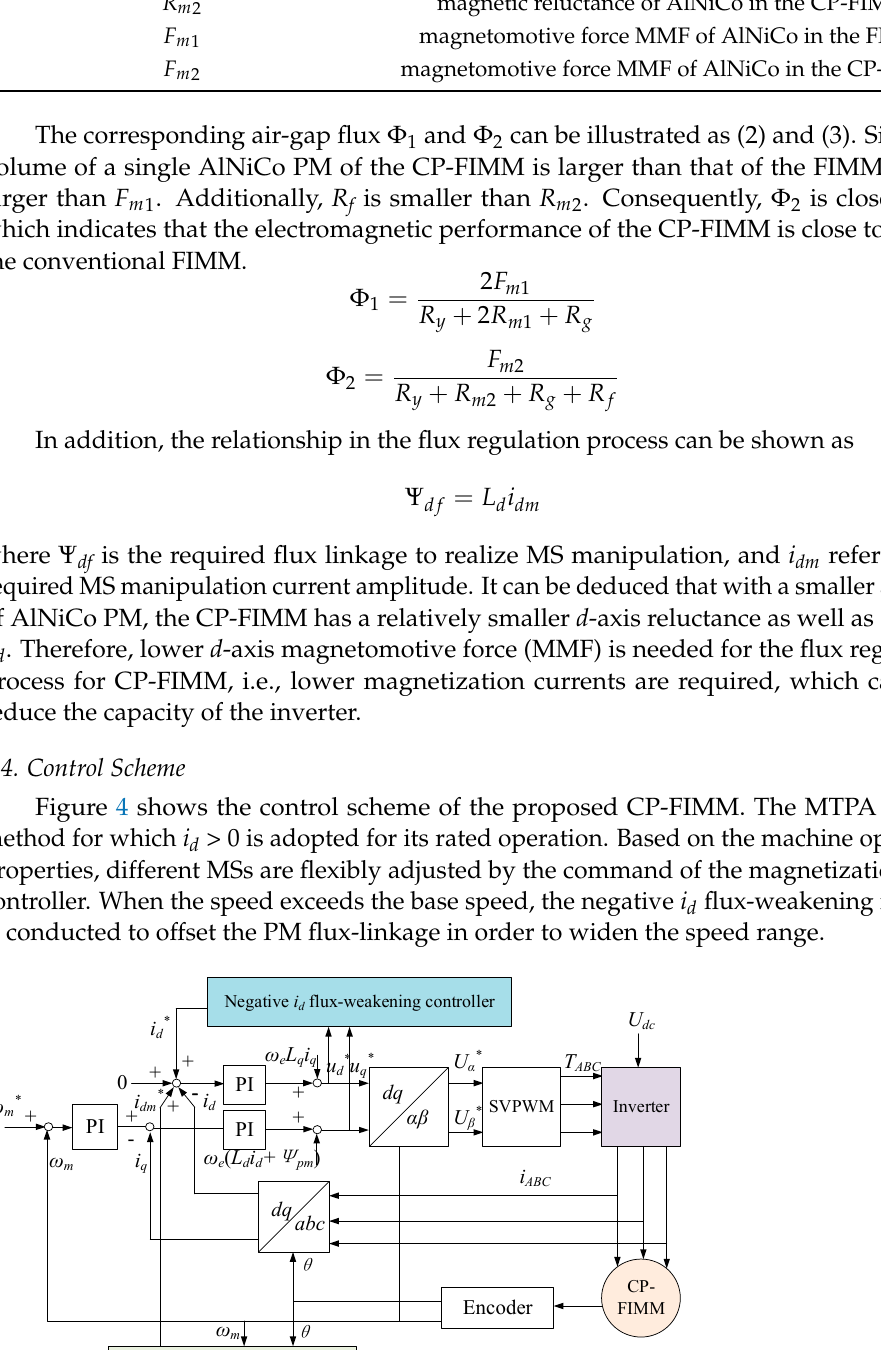
( b ) Figure 5. Flux line distributions under different MSs. ( a ) FIMM; ( b ) CP-FIMM.